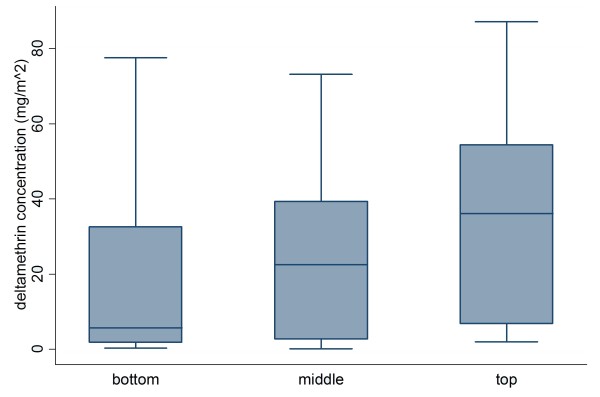
Distribution of deltamethrin in sections from the top, middle, and bottom of LLINs. Boxplots with median, range, quartiles, and outliers are shown. There were significantly lower residual deltamethrin concentrations in the middle and lower sections of the nets (p < 0.0001).